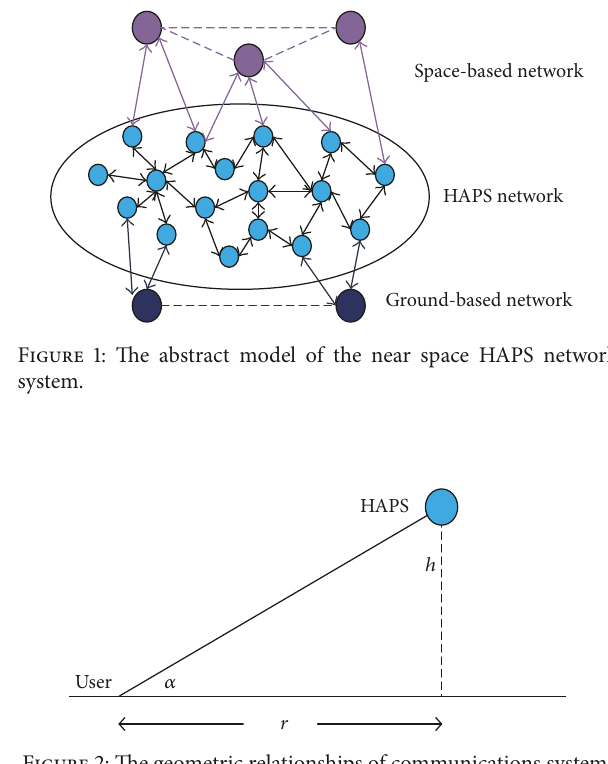
Figure 2: The geometric relationships of communications system.